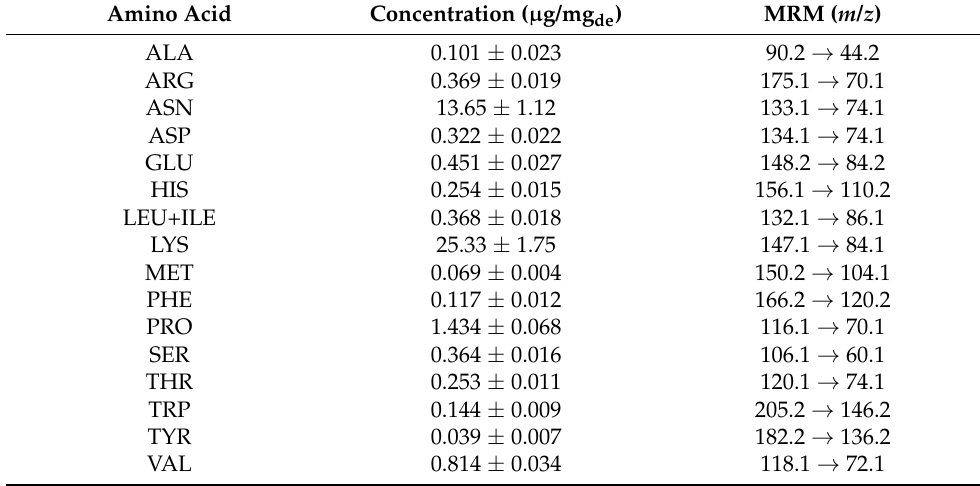
Table 2. Quantitative determination of free amino acids in asparagus hard stem